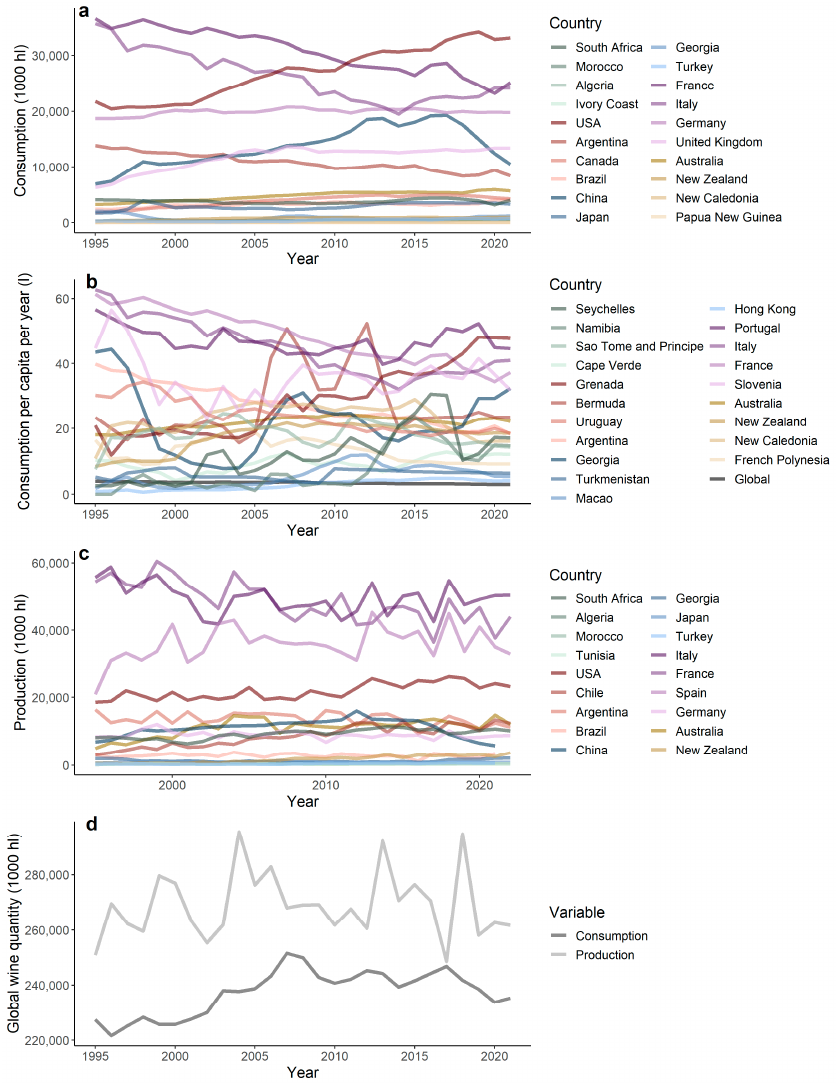
Figure 1. Long-term records of wine industry factors, consisting of four countries from each continent with the highest quantities in 2021 for wine consumption ( a ); wine consumption per capita ( b ); and wine production ( c ). Global trend lines of wine consumption and production are shown in panel ( d ). Countries located in Europe, Africa, America, Oceania, and Asia are denoted by scales of purple, green, maroon, golden-brown, and blue, respectively.